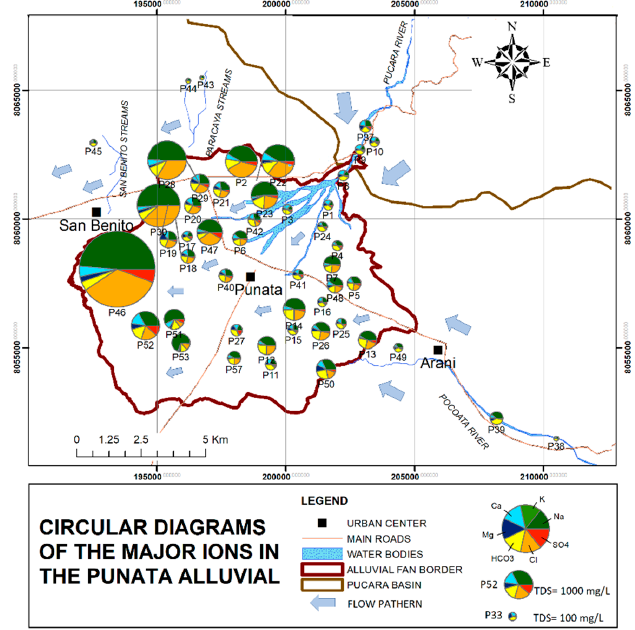
Figure 5. Circular diagrams of the water samples collected within the Punata alluvial. Note that the diameter of the circular diagrams is proportional to the total dissolved solids (TDS) content.